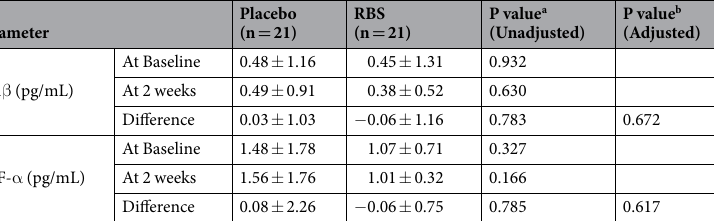
Table 4. Concentration of inflammatory cytokines in serum of participants with sleep disturbance administered RBS or placebo for 2 weeks. Data are expressed as the mean ± standard deviation. a P values refer to independent t-tests, compared with the placebo group. b P values refer to the analysis of covariance, adjusted for caffeine intake as a